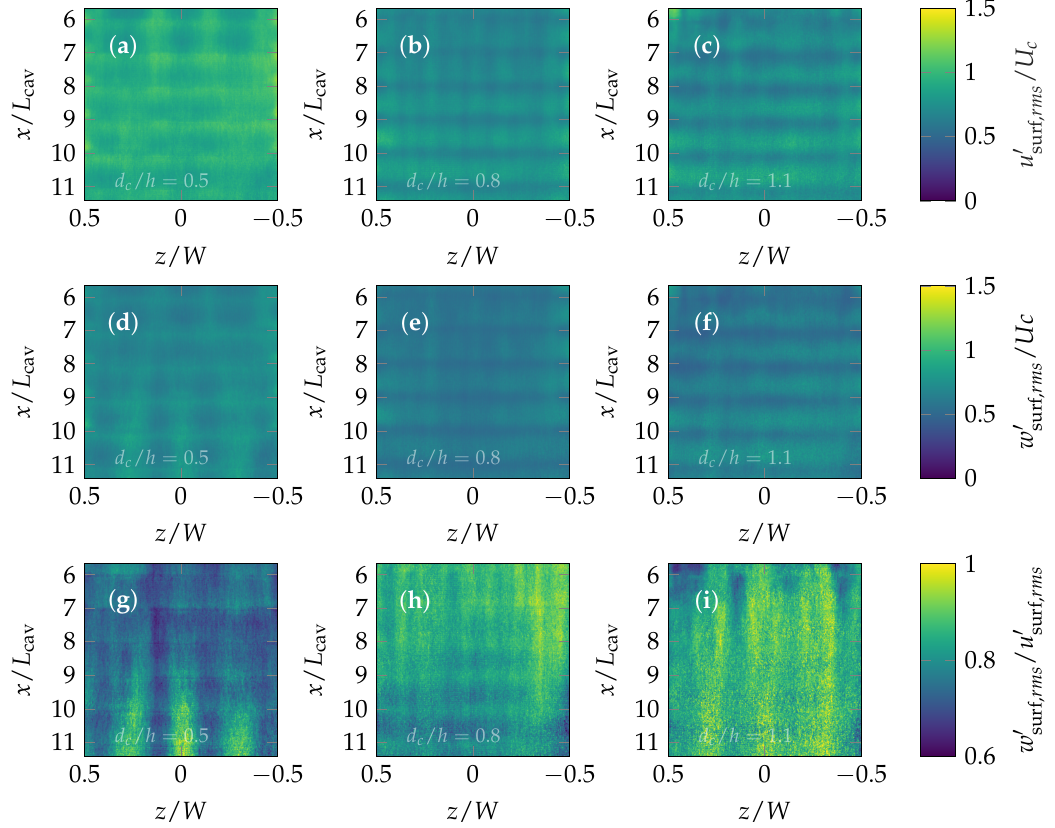
Figure 6. Streamwise and transverse free-surface velocity fluctuations for d c / h = 0.5, 0.8 and 1.1; ( a – c ) streamwise velocity fluctuations ( u (cid:48) ) ( d – f ) transverse velocity fluctuations ( w (cid:48) surf, rms w (cid:48) / u (cid:48) surf, rms surf, rms